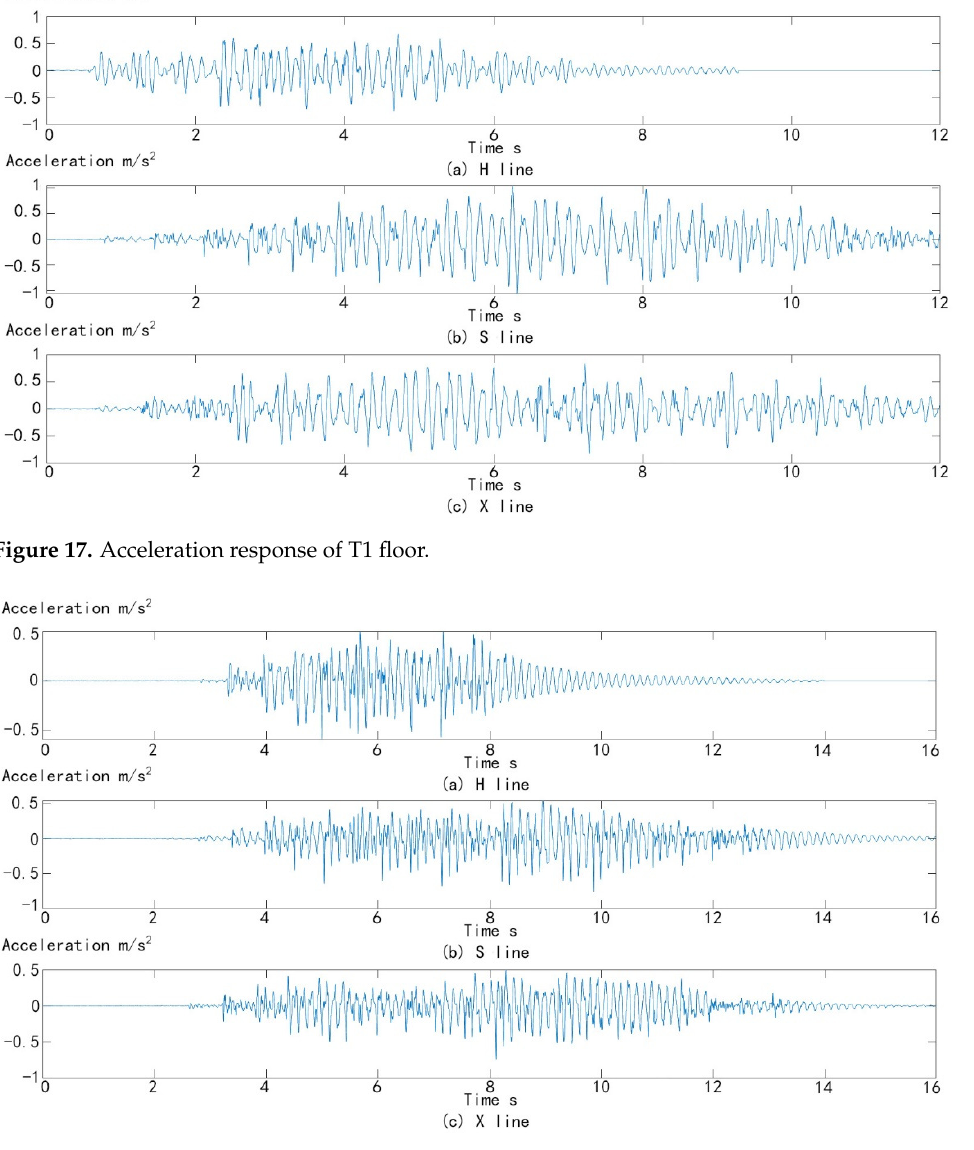
Figure 18. Acceleration response of T2 floor. Table 4. RMS acceleration of the floor under a single person walking load (unit: m/s 2